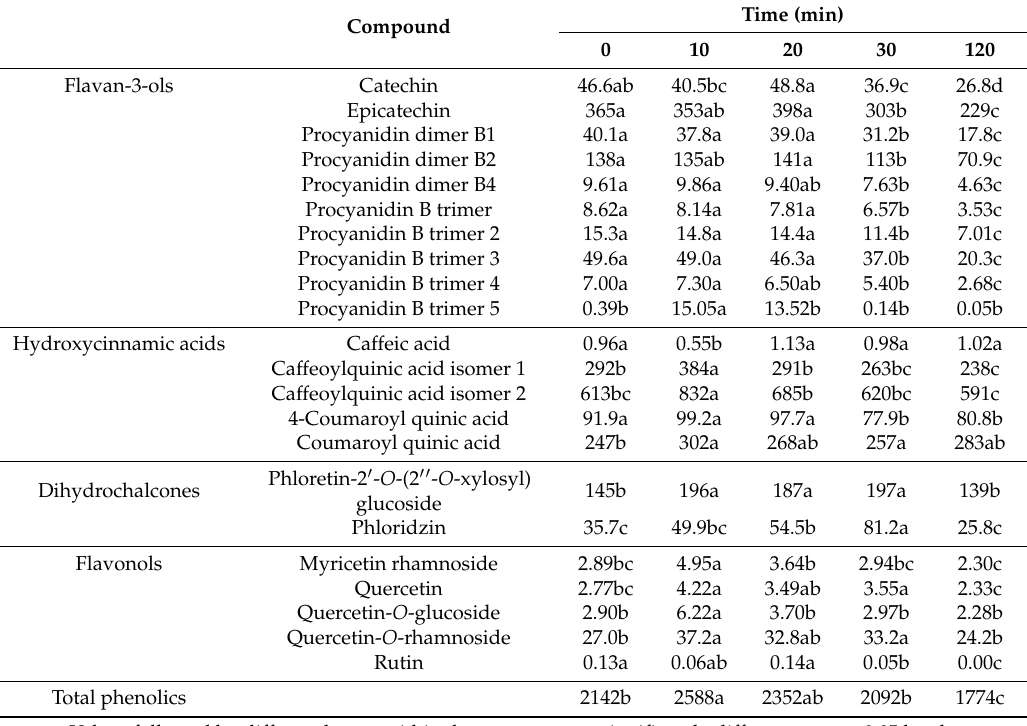
Table 2. Content of phenolics ( µ mol kg − 1 f.w.) of Pink Lady apples, as affected by plasma treatment